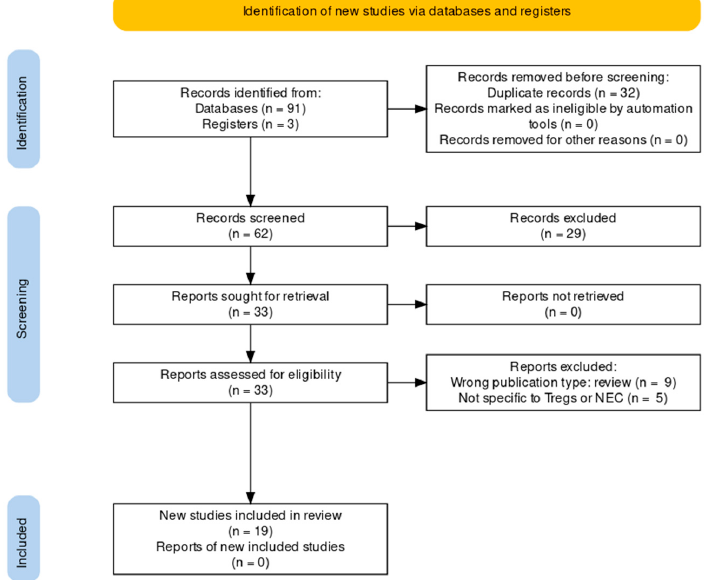
Figure 1. PRISMA flow chart showing locations records were identified from, abstracts from rec- ords screened, full reports assessed and total studies included [12].